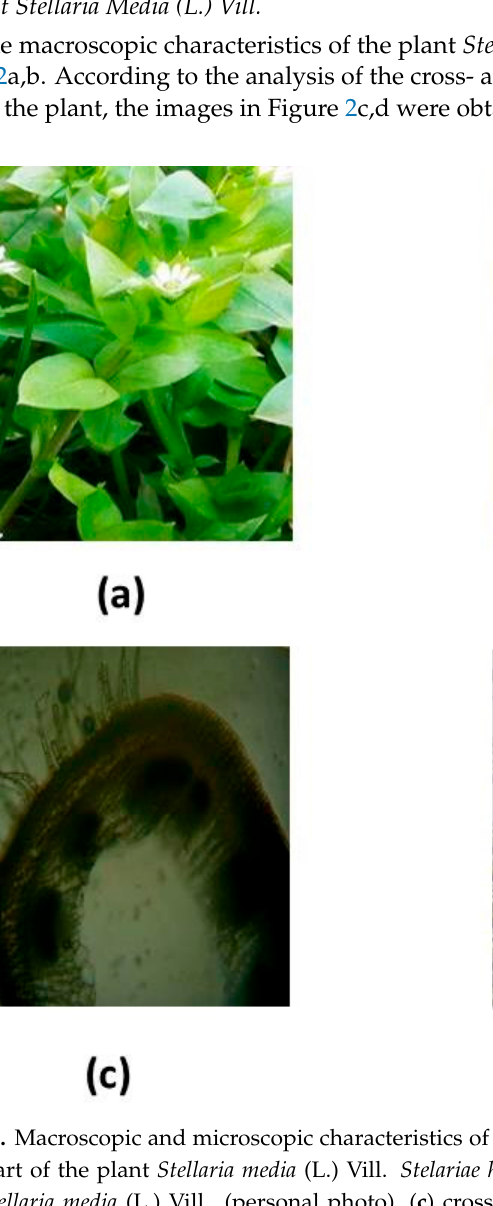
Table 2. Total phenols of Stellaria media (L.) Vill. extract and its antioxidant capacity. Total Phenols Content mgGAE/g d.w.